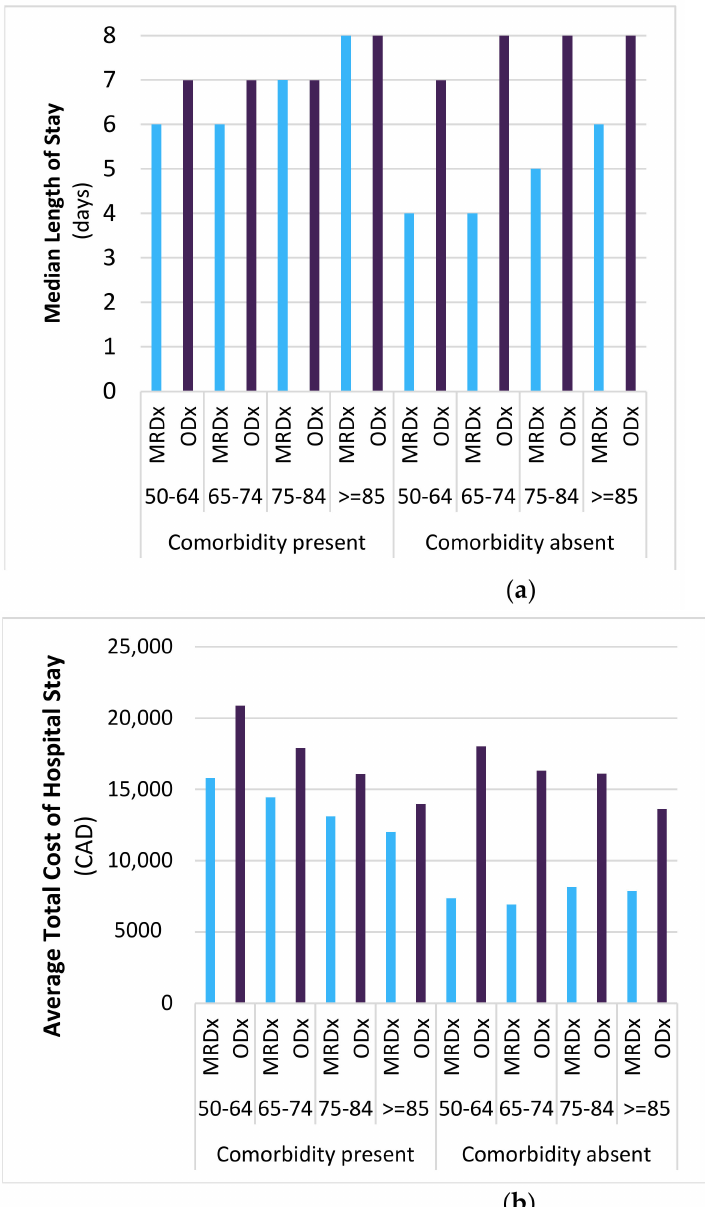
Figure 3. Length of stay and total cost of hospitalization for all-cause community-acquired pneu- monia, by comorbidity, case coding, and age group, in fiscal year 2018, Canada (excluding Quebec). ( a ) The median hospital stay was generally longer for ODx-coded CAP cases, older age groups, and individuals with comorbidity present. ( b ) The average total cost of hospital stay was generally higher for ODx-coded CAP cases, younger age groups, and with comorbidity present. Additional data for fiscal year 2009–2018 are available in Supplementary Table